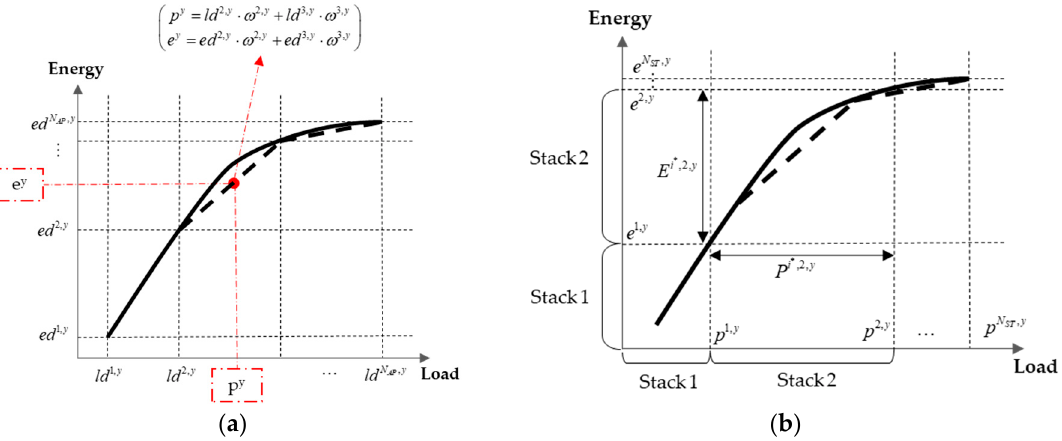
Figure 5. Optimization process for determining the candidate resource: ( a ) Determining the desired point using the SOS2 method; ( b ) Allocating the capacity and utilized energy of a candidate resource.